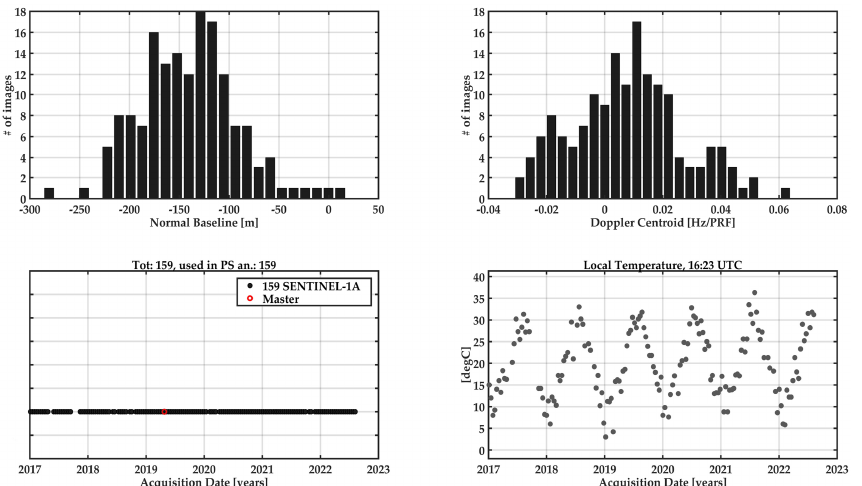
Figure 4. Dataset of the Ascending Orbit. The upper left graph illustrates the normal baseline distribution of image pairs. The upper right graph illustrates the Doppler centroid distribution of image pairs. The lower left graph illustrates the acquisition date range of the data time series. The lower right graph illustrates the local temperature per acquisition date.